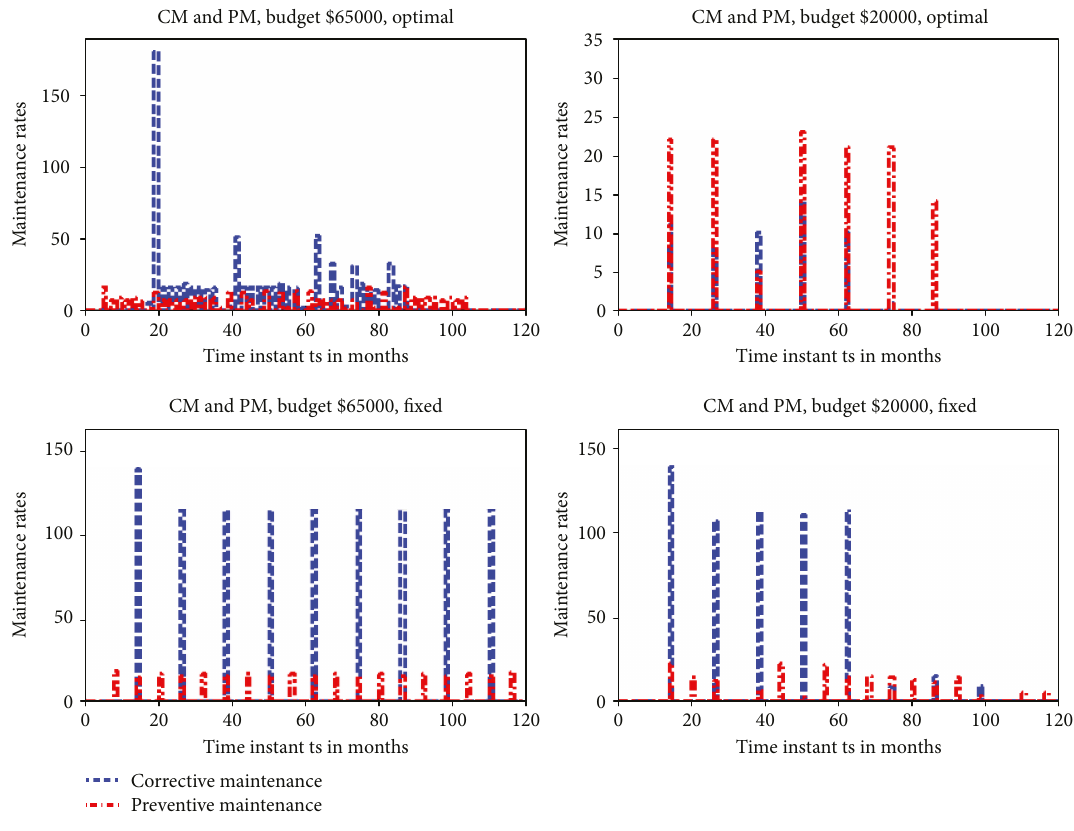
Figure 2: The maintenance rates over time with di ff erent maintenance budgets.